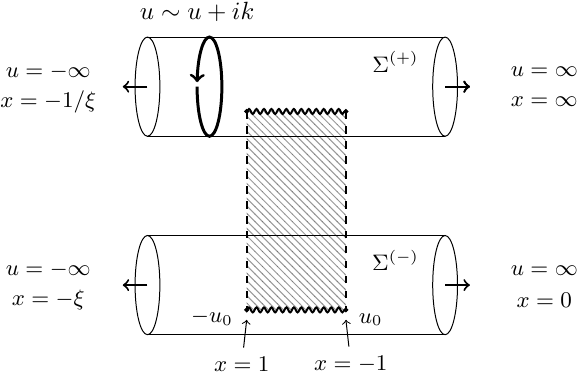
Figure 1 . The underlying surface (cid:6), the double cover of the cylinder u (cid:24) u + ik , with its two sheets (cid:6) ( (cid:6) ) joined by the short cut [ (cid:0) u 0 ; u 0